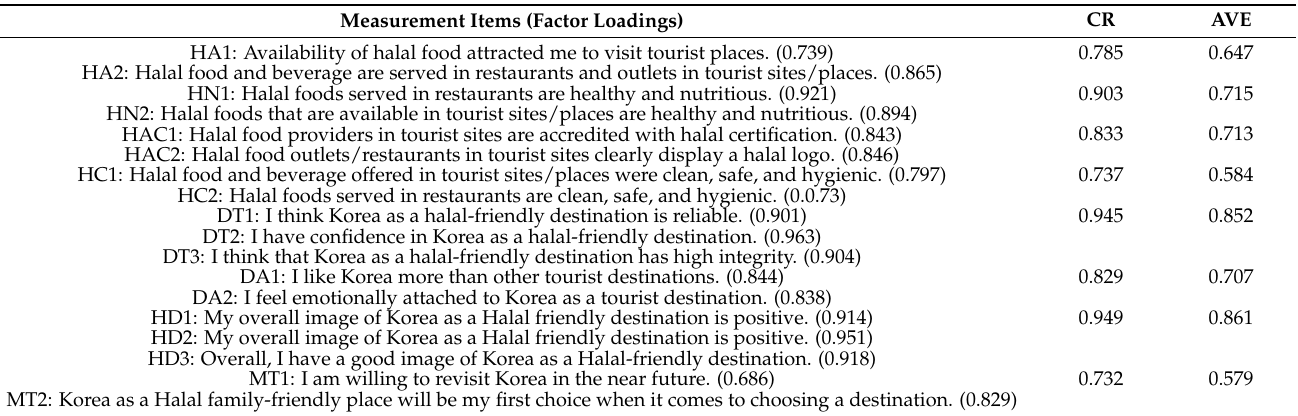
Table 1. A confirmatory factor analysis of measurement items ( n = 326).